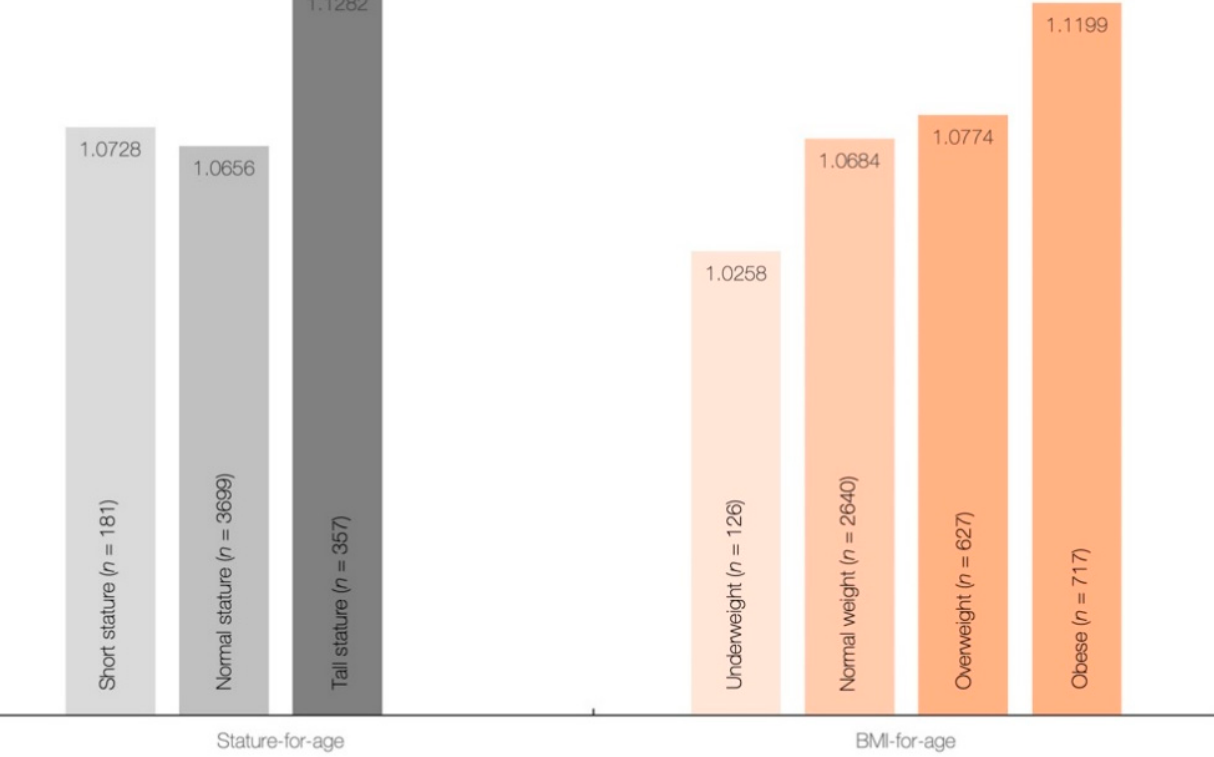
Abbreviations: BMI—body mass index. * Superscript letters indicate a significant difference at p <